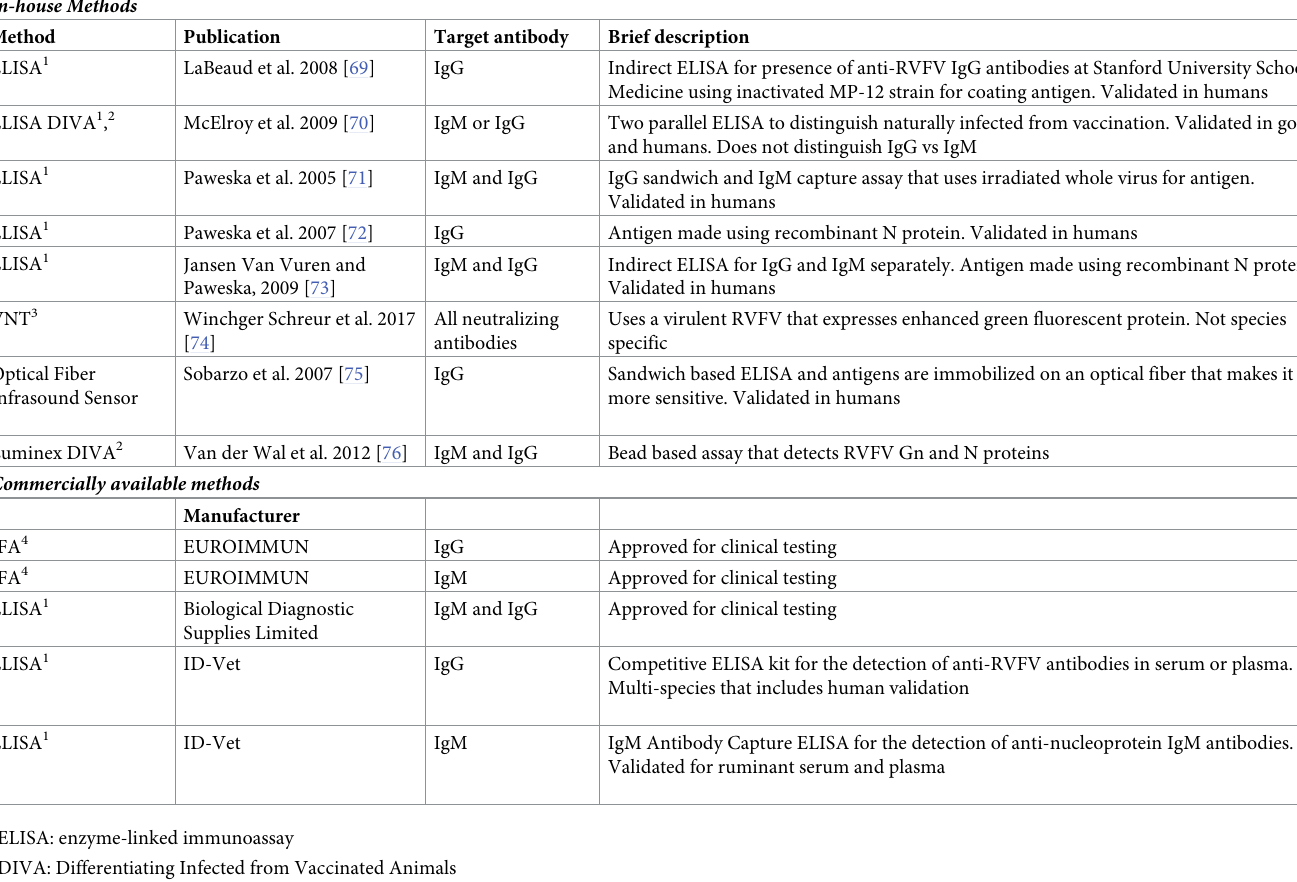
Table 1. Currently used serologic assays for detection of RVFV exposure in humans. In-house Methods